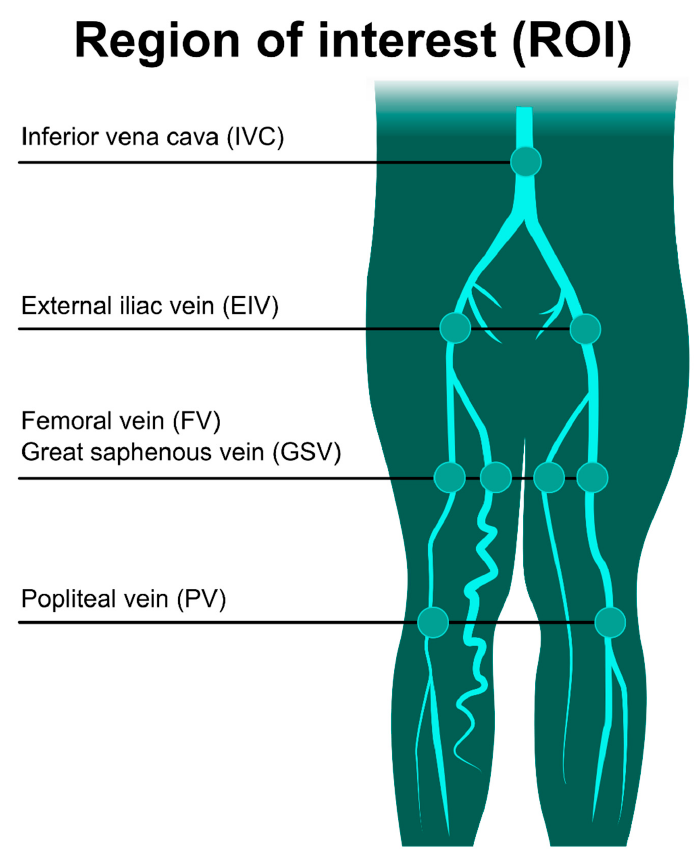
Figure 1. Drawing a region of interest (ROI) for the QFlow analysis. QFlow scanning is performed at four levels to obtain two-dimensional images containing phase shift information. Drawing the ROI on the vascular lumens (covering the whole lumen) obtained hemodynamic variables for the statistical analysis. After defining at least one contour area of ROI, the computer could automatically generate analysis results of various variables. These variables include stroke volume (SV), forward flow volume (FFV), backward flow volume (BFV), regurgitant fraction (RF), ab- solute stroke volume (ASV), mean flux (MF), stroke distance (SD), and mean velocity (MV). All these QFlow parameters were used for analysis as objective indicators.